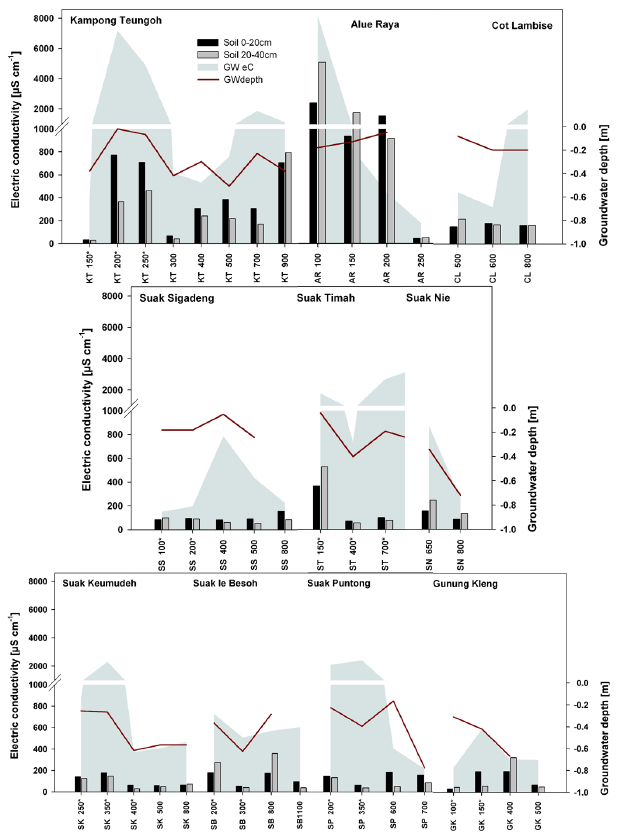
Fig. 3. Spatial distribution of soil and groundwater electric conduc- tivity and groundwater depth in 2007. Plot indices are composed of village code and distance to seawater (m). Asterisks indicate plots flooded in May